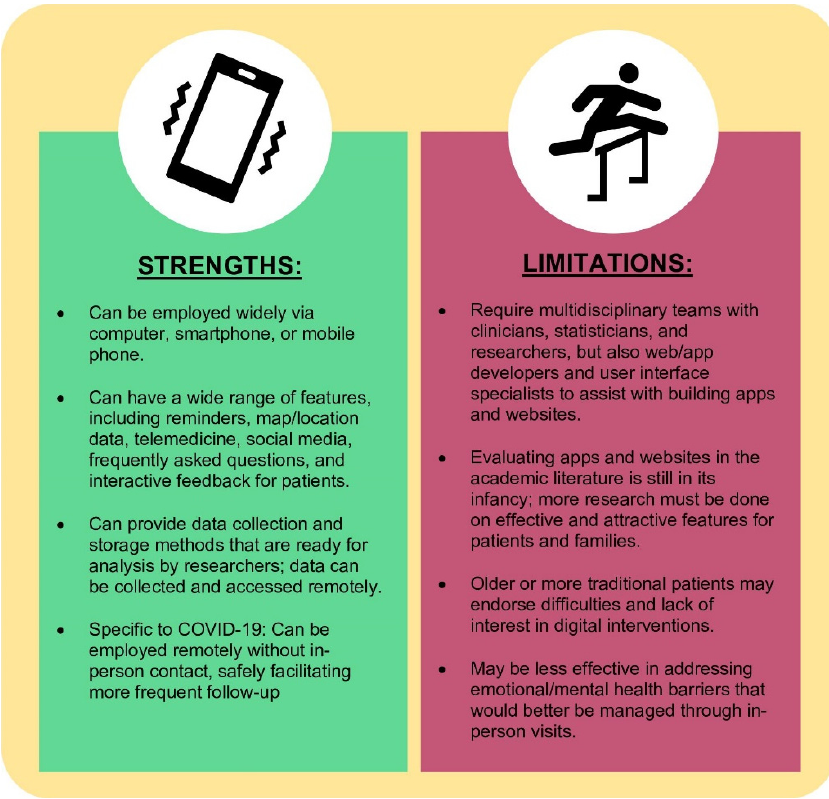
Figure 1. Strengths and limitations of using digital approaches in heart transplant.